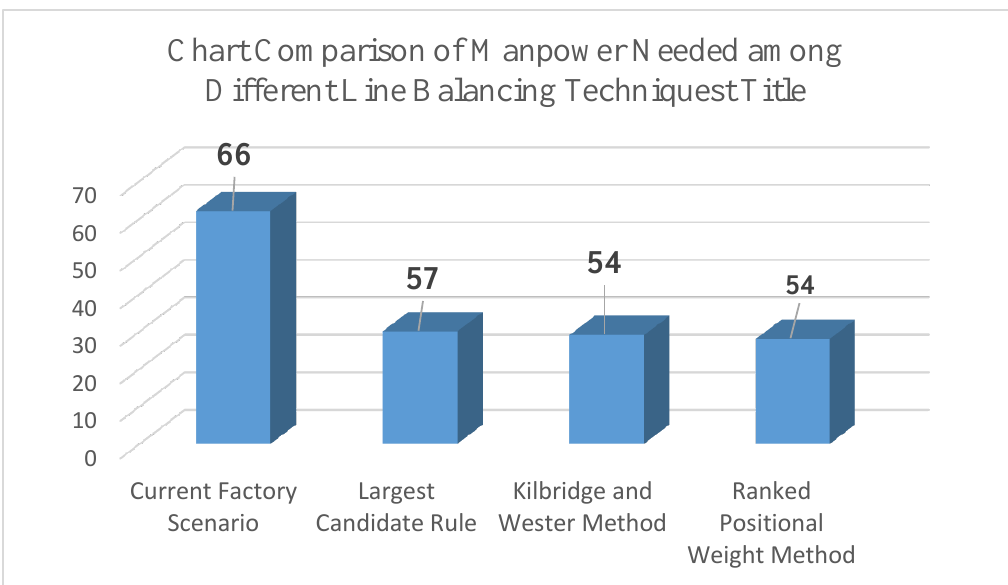
Figure 12. Comparison of manpower needed among different line balancing techniques.